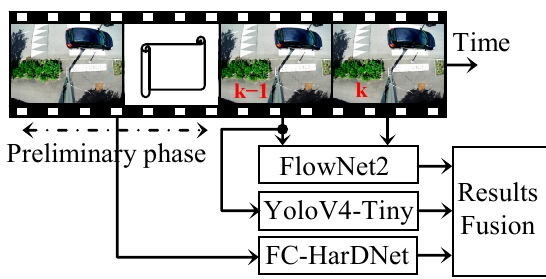
Figure 10. The overall structure of the fusion process.